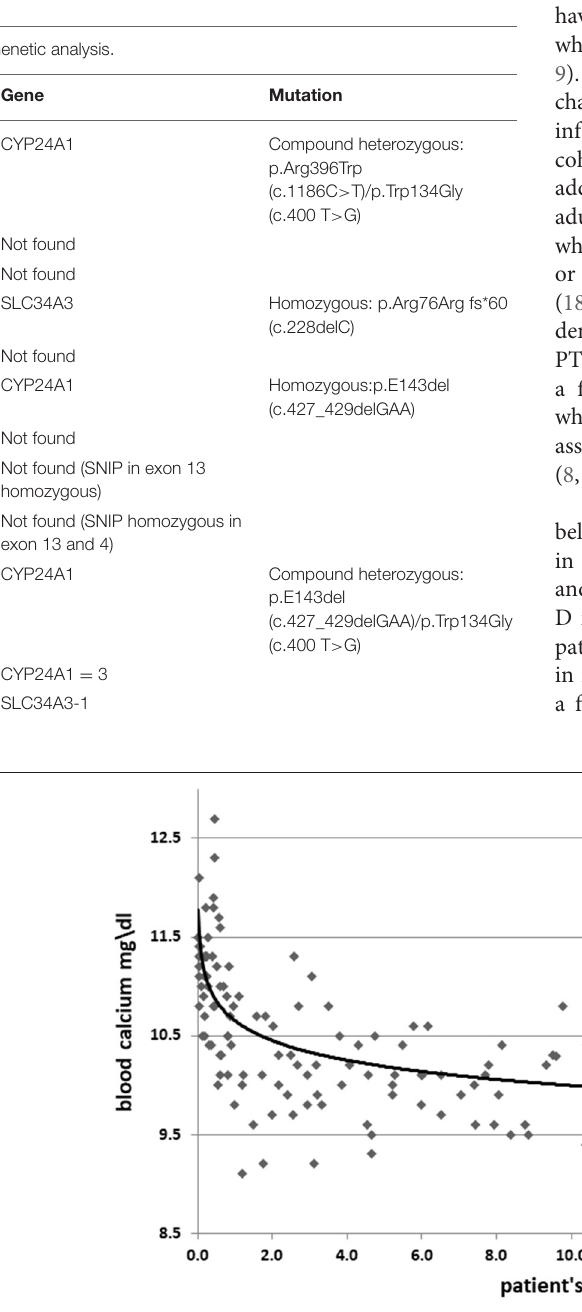
FIGURE 1 | Blood calcium levels according to patient age. Y,